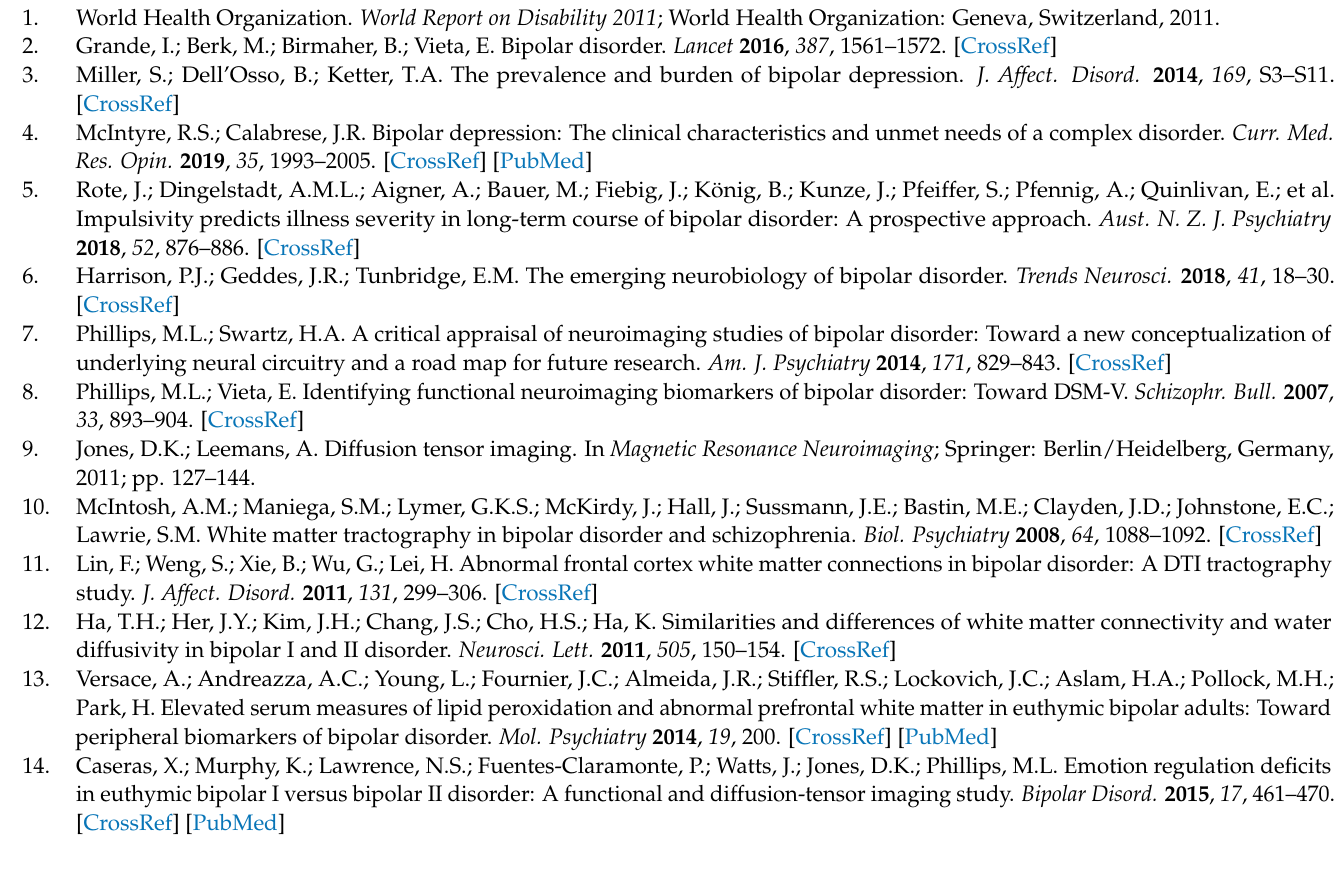
Table S12. Correlations between percentage of time taking medications pre-scan and node clusters identified in Level 1 analysis. Supplementary References